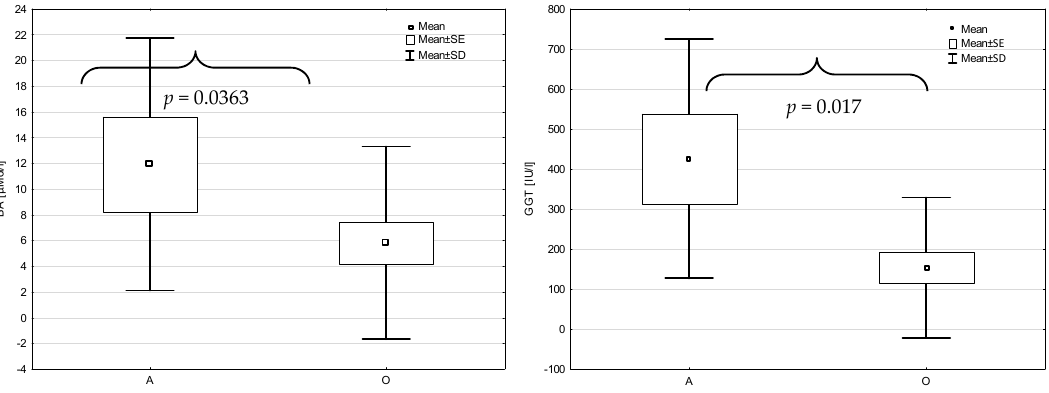
Figure 2. The concentration of bile acids (BA) and the activity of GGT in the acute pancreatitis of alcoholic (A) and other (O) etiologies.